Question: What does this figure show? Answer in one sentence.
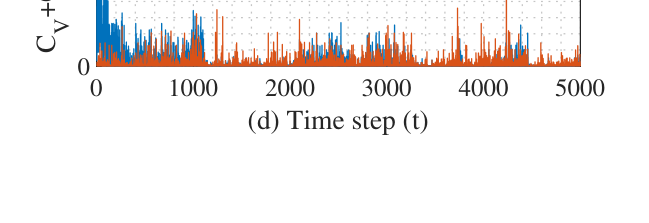
Answer: (a) The input request to node 1. The rest inputs are analogous. (b) The average regret of both methods. (b) The Euclidean distance between two consecutive probability distributions produced by Algorithm 1. (c) Reservation cost (C(At)) for each time slot t. (d) The blocking cost (C0(At, Bt)) .